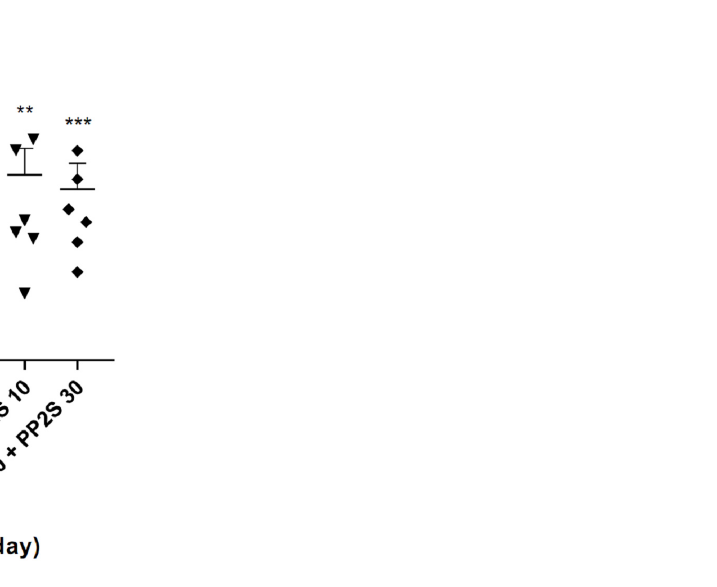
Figure 4. Synergistic effect of PPs and ethionamide (ETH) in the pulmonary tuberculosis mouse model. In the mouse model infected with M. tuberculosis , the load of M. tuberculosis in the lungs was lower in the group administered with PP2S and ETH in combination than in the group administered with ETH alone. Data are expressed as mean ± standard deviation. Student’s t -test was used to compare groups (* p < 0.05, ** p < 0.01, *** p < 0.001). Table 1. Effectiveness of PPs in combination with first-line anti-tubercular drugs.